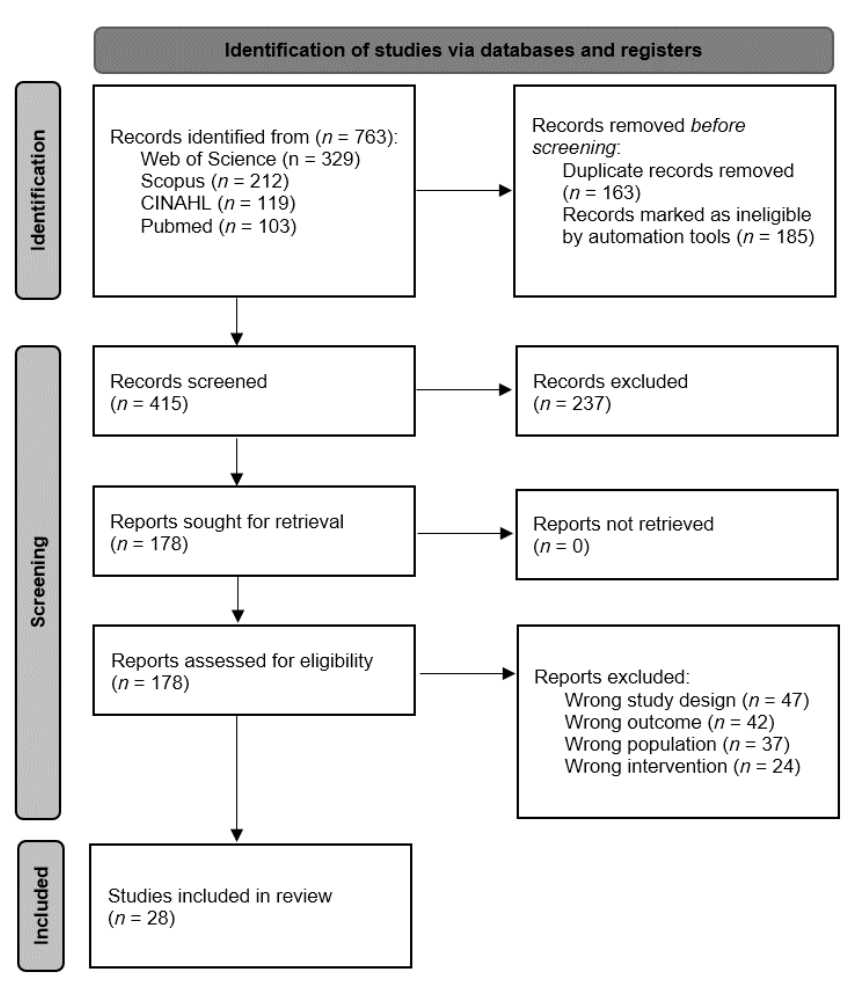
Figure 1. Flow diagram of the study selection process.